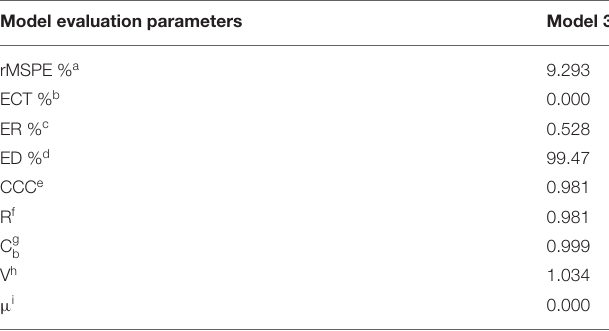
TABLE 3 | Results of root mean square prediction error (rMSPE) and concordance correlation coefficient (CCC) analysis of the Model 3. Model evaluation